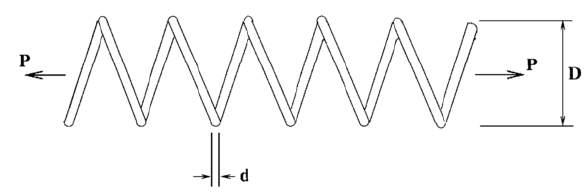
Figure 5. Schematic of the tension/compression